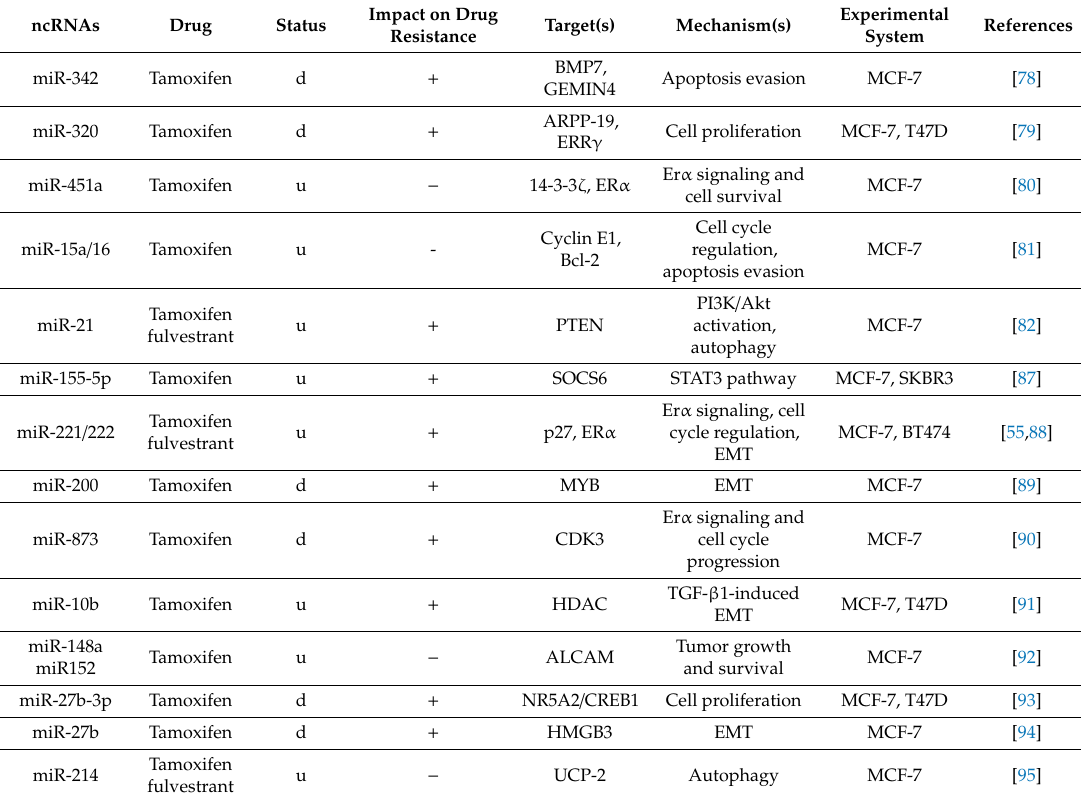
Table 1. miRNAs regulating endocrine resistance in BC 1 ; (u) upregulated; (d) downregulated; ( + ) increase; ( − )